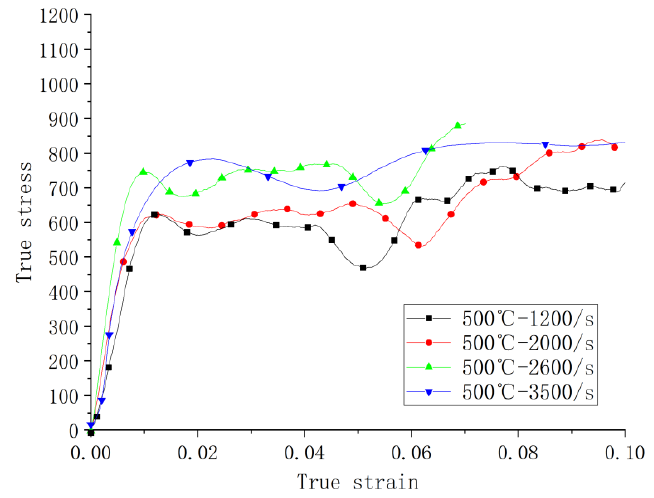
Figure 11. Stress–strain curves of compression tests at 500 °C.